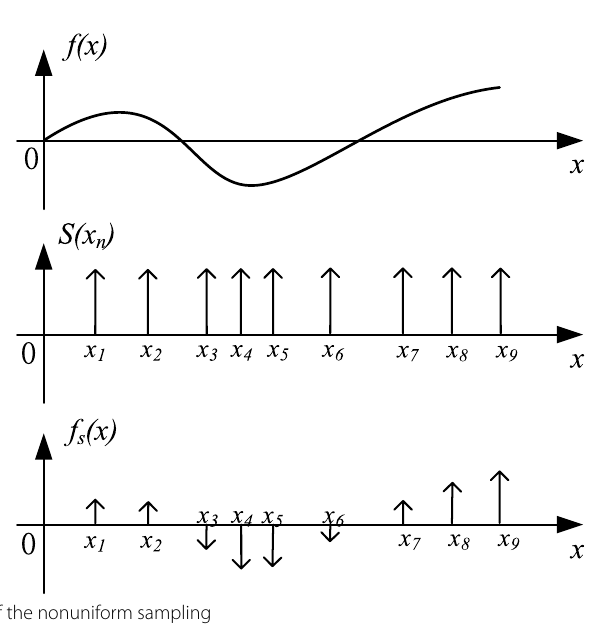
Fig. 3 Process of the nonuniform